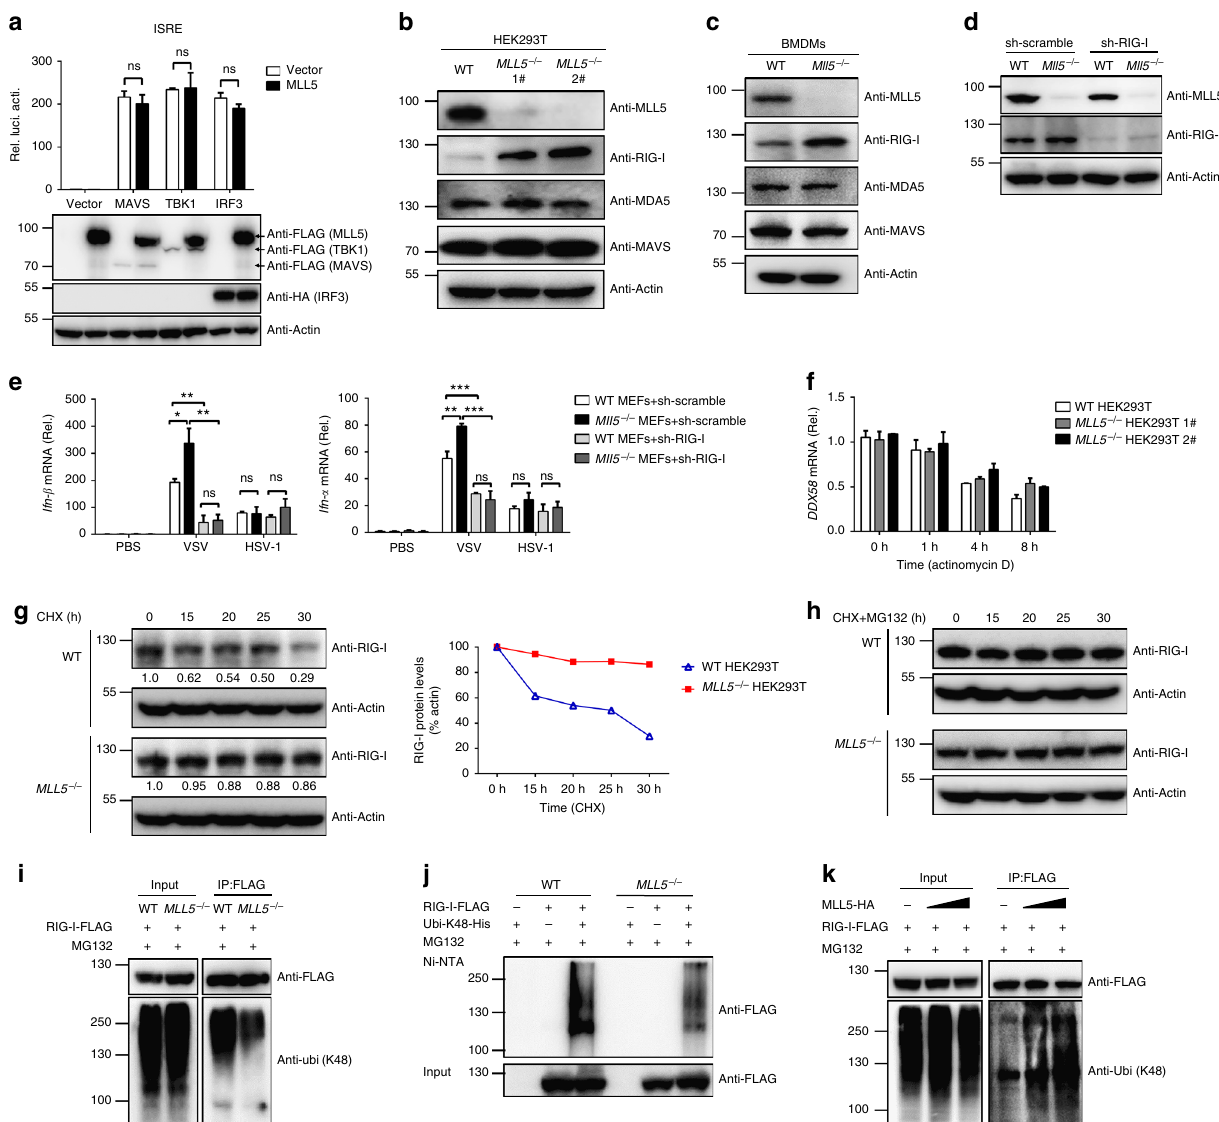
Fig. 4 MLL5 de fi ciency results in accumulation of RIG-I protein. a Luciferase activity of ISRE promoter reporter in HEK293T cells transfected with expression plasmids for MAVS-FLAG (200 ng), TBK1-FLAG (200 ng) or IRF3-HA (200 ng) along with MLL5-FLAG (600 ng) or empty control vector (600 ng) for 24 h. Results were presented relative to the luciferase activity in control cells (transfected with luciferase reporter and empty vector). Immunoblot analysis of MAVS-FLAG, TBK1-FLAG, MLL5-FLAG or IRF3-HA are shown below. Actin served as a loading control. b , c Immunoblot analysis of MLL5, RIG-I, MDA5, and MAVS in WT and MLL5 − / − HEK293T cells ( b ) or in BMDMs from WT and Mll5 − / − mice ( c ). d Immunoblot analysis of MLL5 and RIG-I in WT and Mll5 − / − MEFs with RIG-I knockdown. Actin served as a loading control. e Expression of Ifn- β and Tnf- α mRNA in WT and Mll5 − / − MEFs with RIG-I knockdown infected with VSV-GFP (MOI:0.5) and HSV-1 (MOI:1) for 6 h. Gapdh served as a control. f Expression of DDX58 mRNA in WT and MLL5 − / − HEK293T cells treated with actinomycin D (1 μ g/ml) for indicated times. GAPDH served as a control. g , h Immunoblot analysis of RIG-I in WT and MLL5 − / − HEK293T cells treated with CHX (100 μ g/ml) ( g ) or CHX (100 μ g/ml) and MG132 (30 μ M) ( h ). Actin served as a loading control. Relative band densities indicating protein levels are shown blown each band ( g ). Quanti fi cation of relative RIG-I protein levels is shown in the right panel. Band density indicating protein amount was quanti fi ed using Image J software. i Co-immunoprecipitation and immunoblot analysis of K48-linked polyubiquitination of RIG-I in WT and MLL5 − / − HEK293T cells transfected with RIG-I-FLAG. j His-pull down and immunoblot analysis of K48-linked polyubiquitination of RIG-I